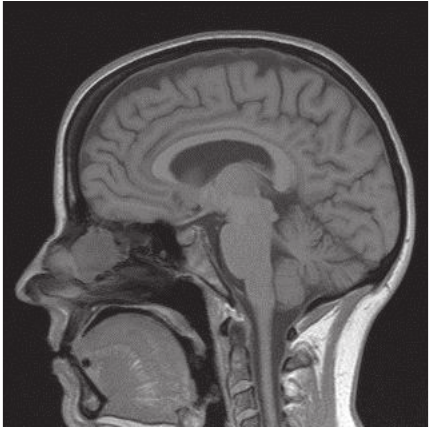
Figure 2: T1-weighted sagittal MRI of the nasal cavity